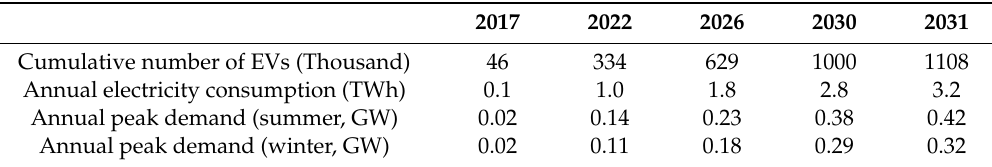
Table 1. Charging demand of EV estimated in 8th